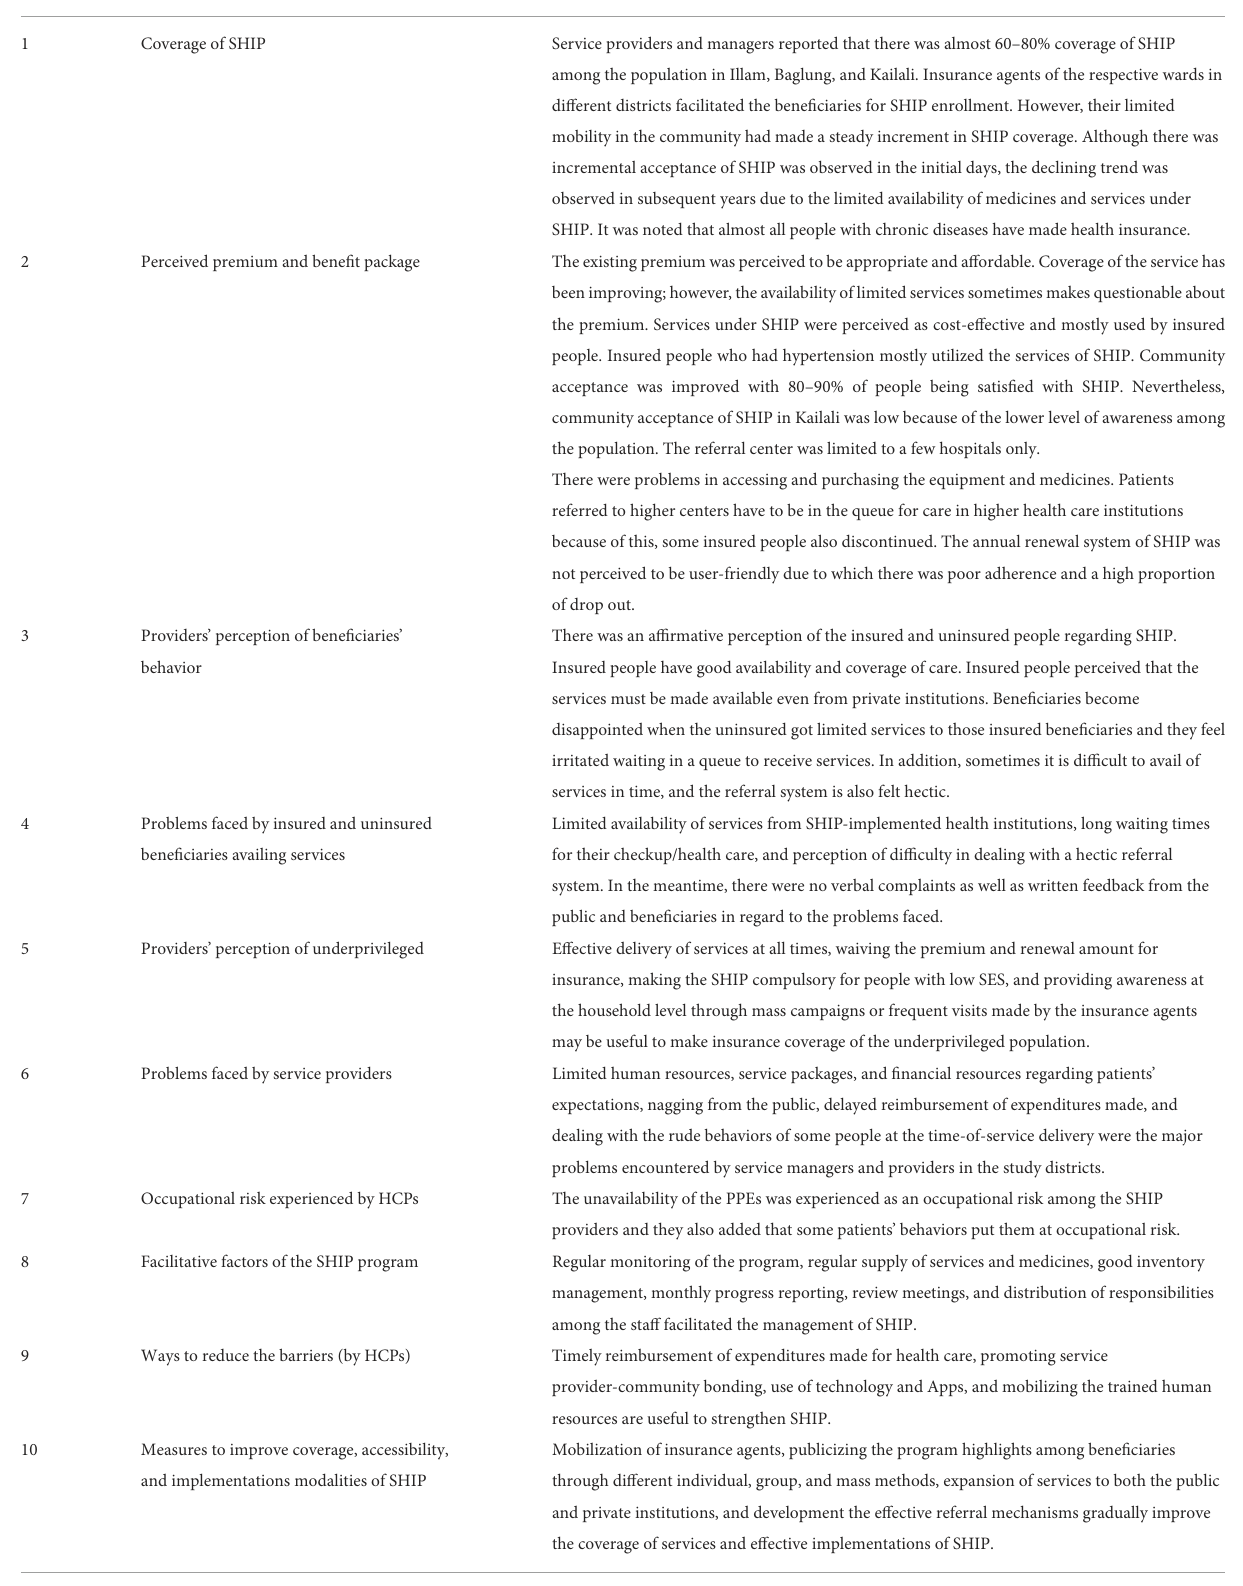
TABLE 6 Summary findings from service providers (qualitative).